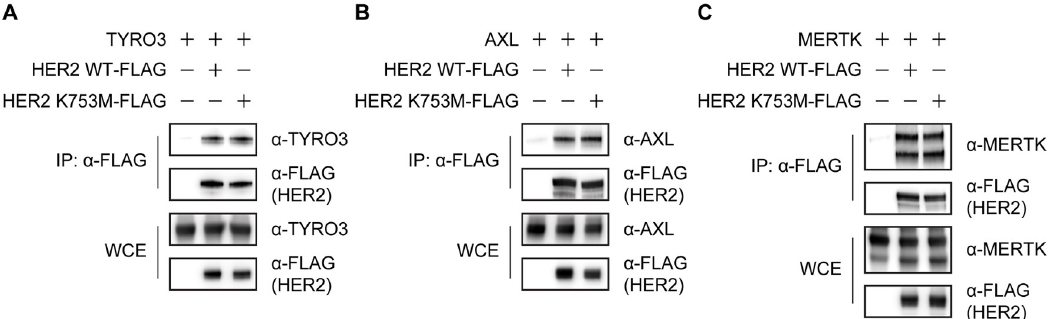
Fig 5. Interaction of HER2 with TAM receptors. Interaction between HER2 and TYRO3 (A), AXL (B), or MERTK (C) in HEK- 293T cells transfected with the indicated combination of expression vectors. Cell lysates were immunoprecipitated with anti-FLAG antibody and then immunoblotted. Data are representative of three independent experiments. IP, immunoprecipitation. WCE, whole-cell extract.